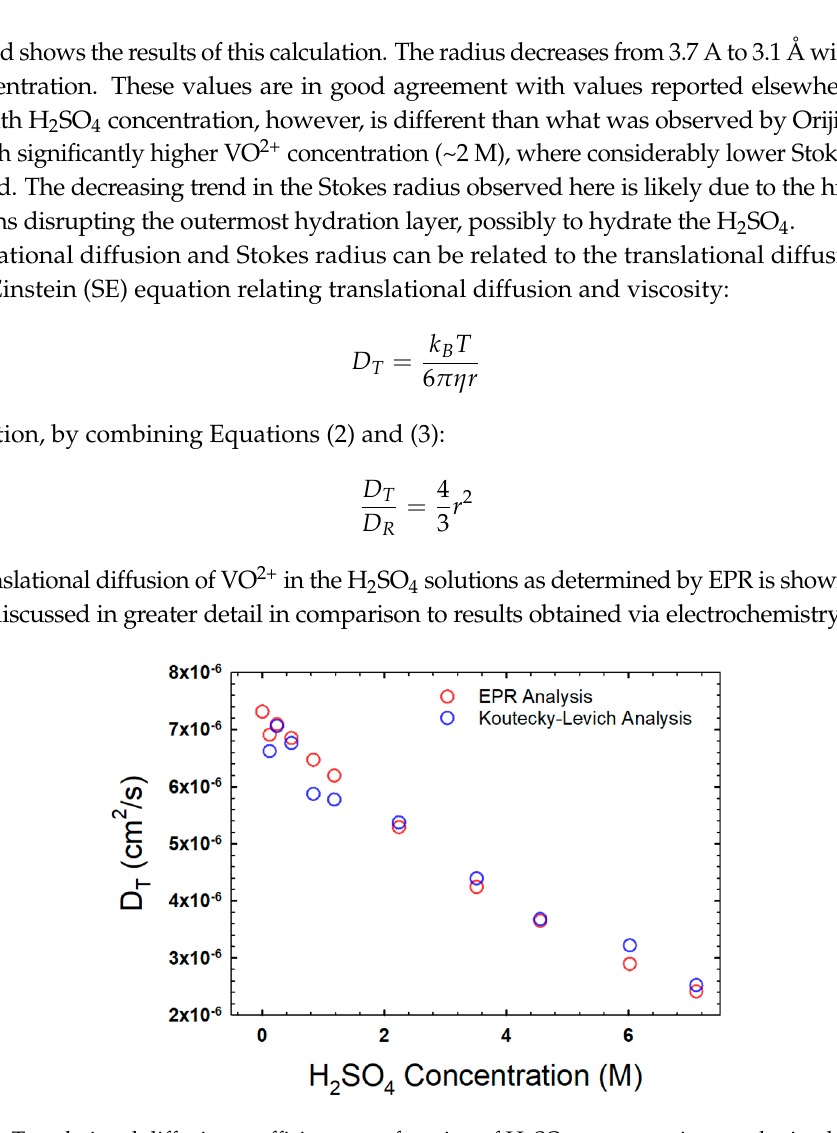
Figure 3. Translational diffusion coefficients as a function of H 2 SO 4 concentration, as obtained via EPR (red circles) and rotating disc electrode analyses (blue circles). Both datasets are measured at 25 °C.